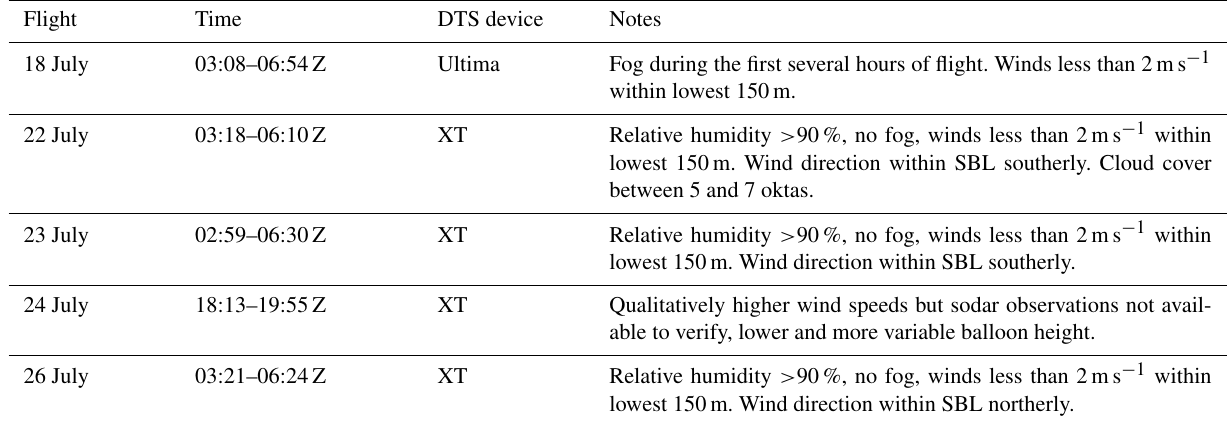
Table 1. Details for the FLYing Fiber Optic eXperiment – Voitsumra (FlyFOX-V). Flight Time DTS